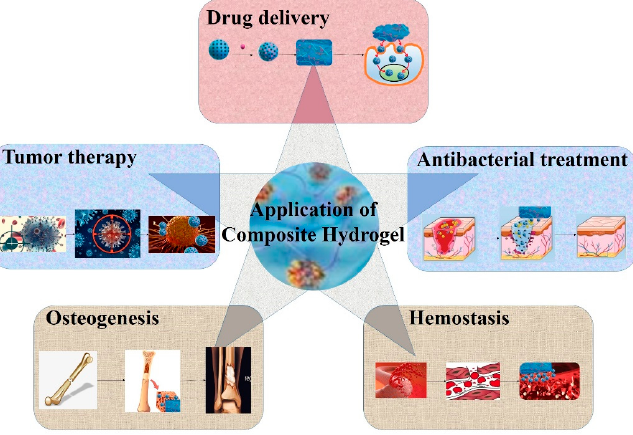
Figure 2. The application of mesoporous material-loaded composite hydrogels.